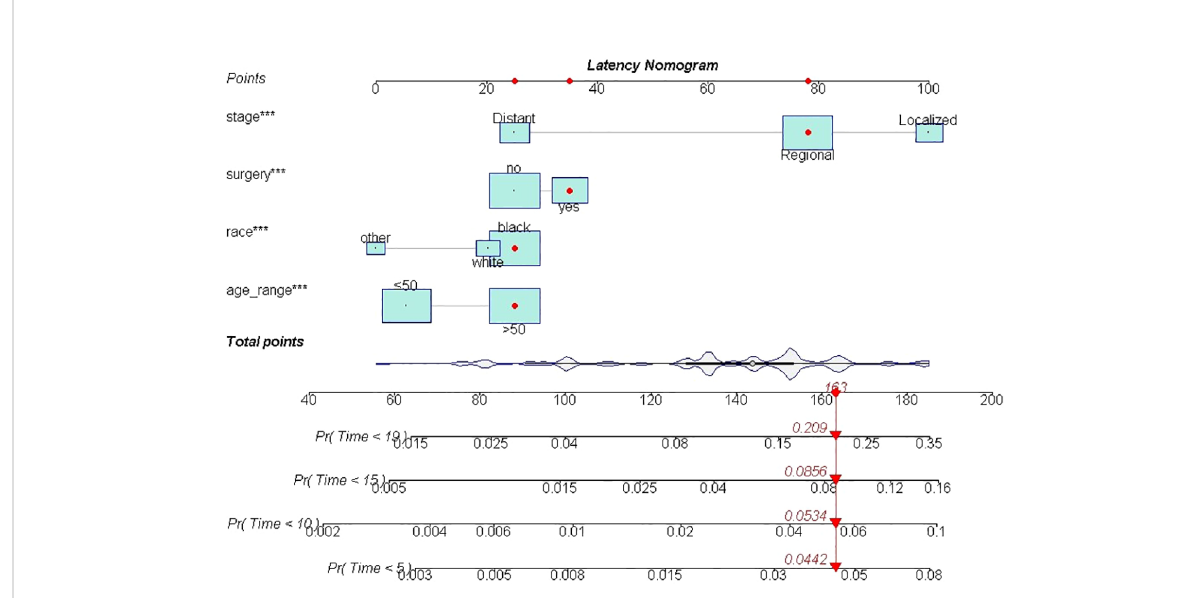
FIGURE 9 The nomogram of predicting the latency between cervical cancer and SPM. ***, It meant pvalue less than